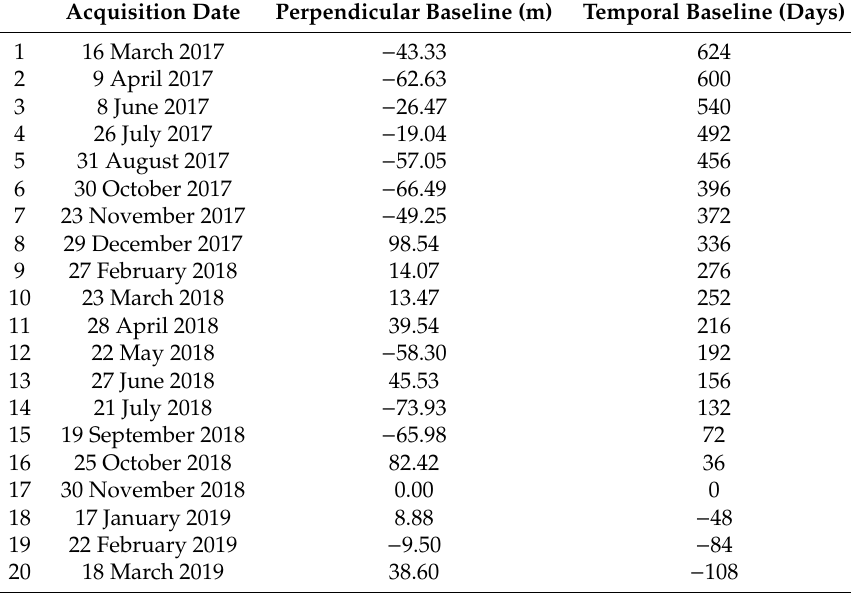
Table 2. Seintinel-1A single look complex (SLC) dataset for Tianjin study area (the perpendicular and temporal baseline is relative to the image received on 30 November 2018).